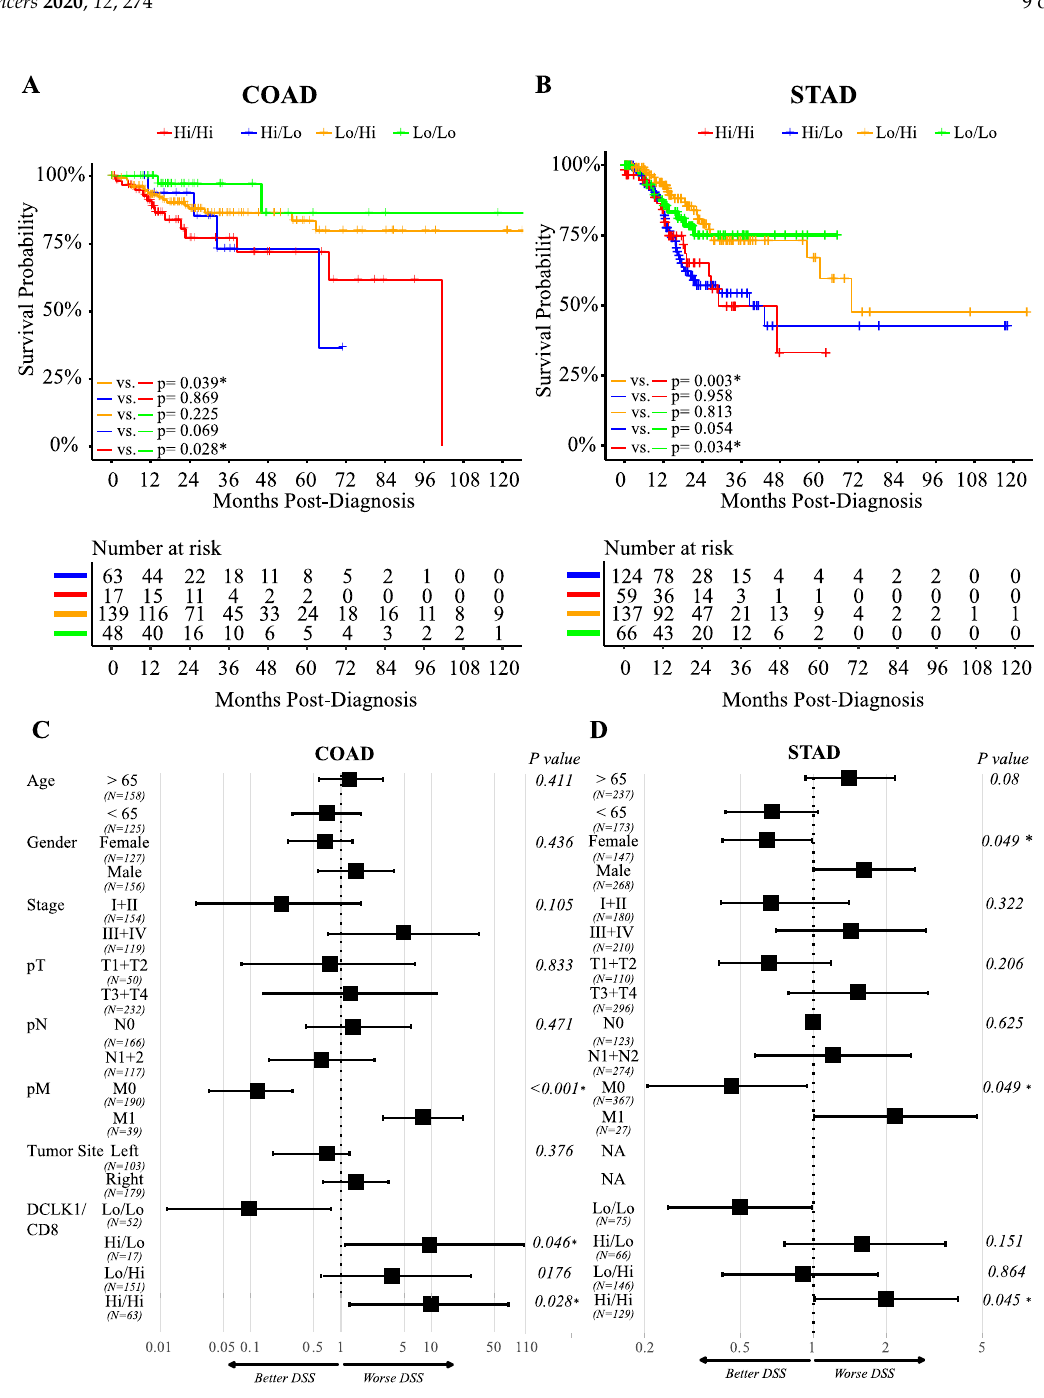
Figure 6. DCLK1/CD8 status predicts DSS of colon and stomach cancer patients. Kaplan–Meier analysis of composite DCLK1 and CD8 status based on mRNA expression in COAD ( A ) and STAD ( B ). DCLK1Lo/CD8Lo (green line) patients presented with better survival times than DCLK1Hi/CD8Hi (red line) for COAD and STAD. DSS times of COAD and STAD patients with lower DCLK and higher CD8 (yellow line) were better than higher DCLK1 and higher CD8 (red line). Cox regression analysis of patients in COAD ( C ) and STAD ( D ) indicated that combined high DCLK1 and high CD8 mRNA expression is an independent indicator of prognosis. DCLK1 Lo/CD8Lo was used as the control group for all statistical comparisons.